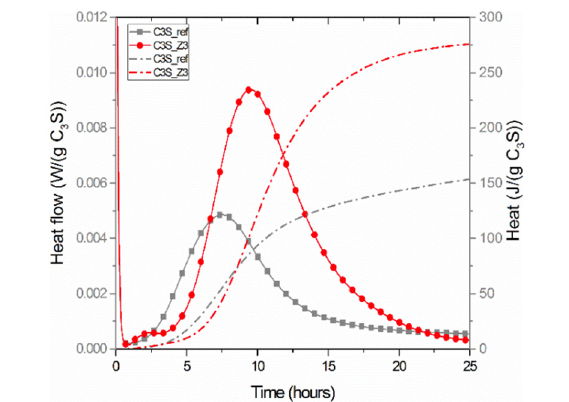
Figure 2. Calorimetry of C 3 S with and without ZnO doping from [10]. The grey curves are for the reference pure C 3 S, while the red curves are for C 3 S doped with 3% zinc. In each case the solid curve is the heat flow (left axis) and the dotted curves the cumulative heat (right axis). Further details on the sample preparation are in the original